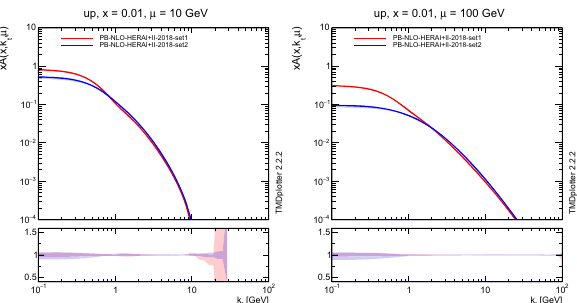
Fig. 2 TMD parton distributions for up quarks (PB-NLO-2018-Set1 and PB-NLO-2018-Set 2) as a function of k T at μ = 10 and 100 GeV and x = 0 . 01. In the lower panels the full uncertainty of the TMDs is shown, as obtained from the fits